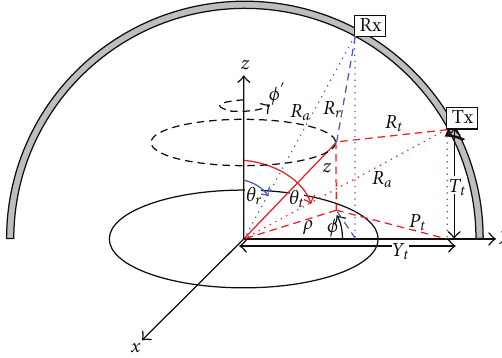
Figure 10: Bistatic SWISAR geometry (for which the monostatic geometry is a subset).